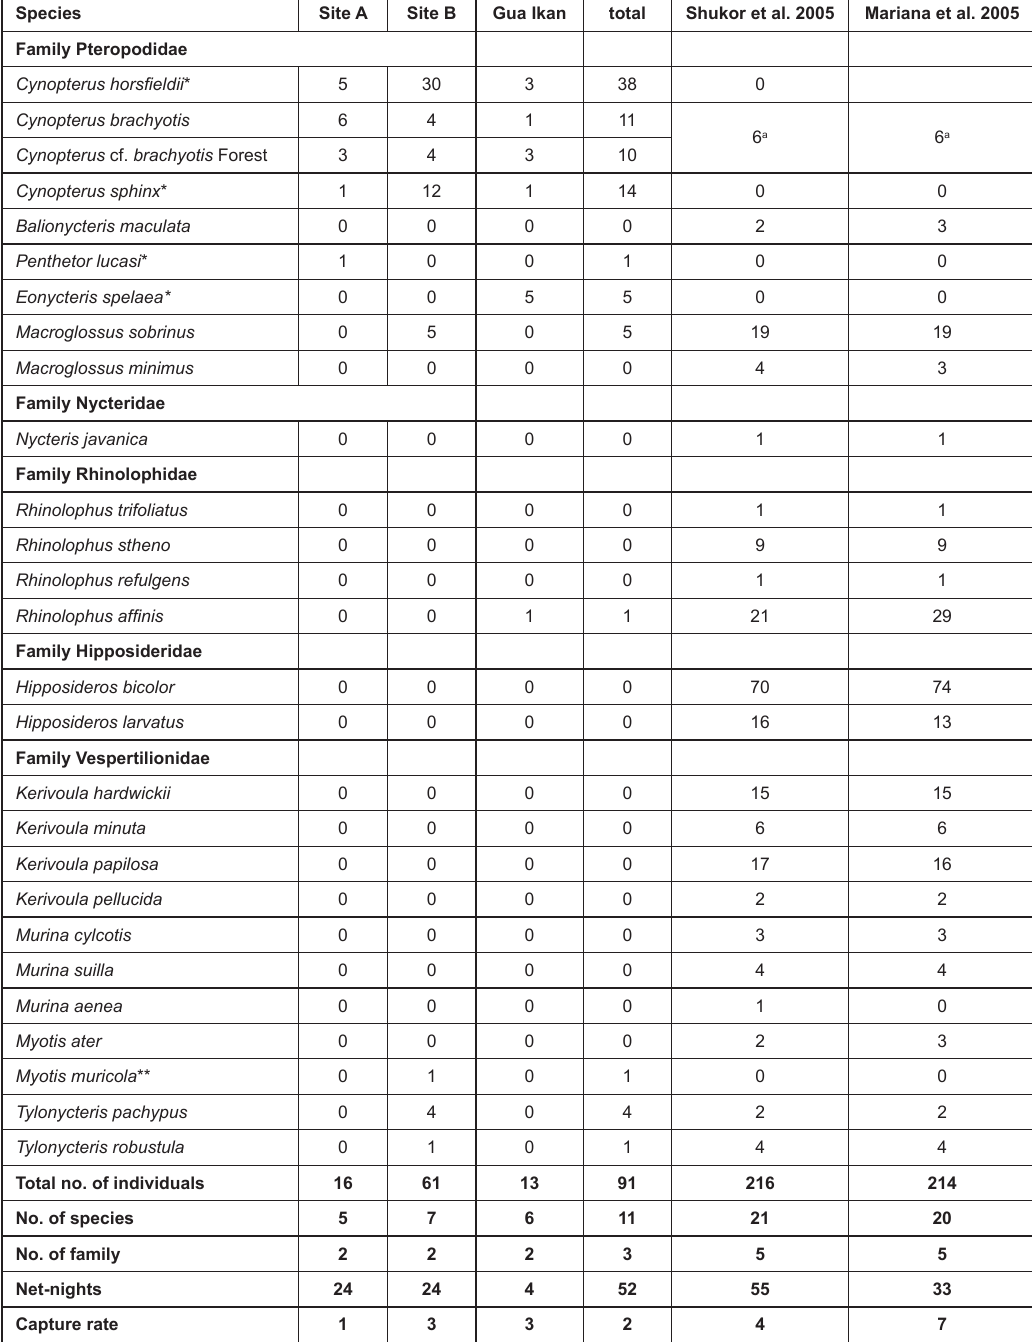
Table 1. List of species caught, net nights and capture rate of bats in this